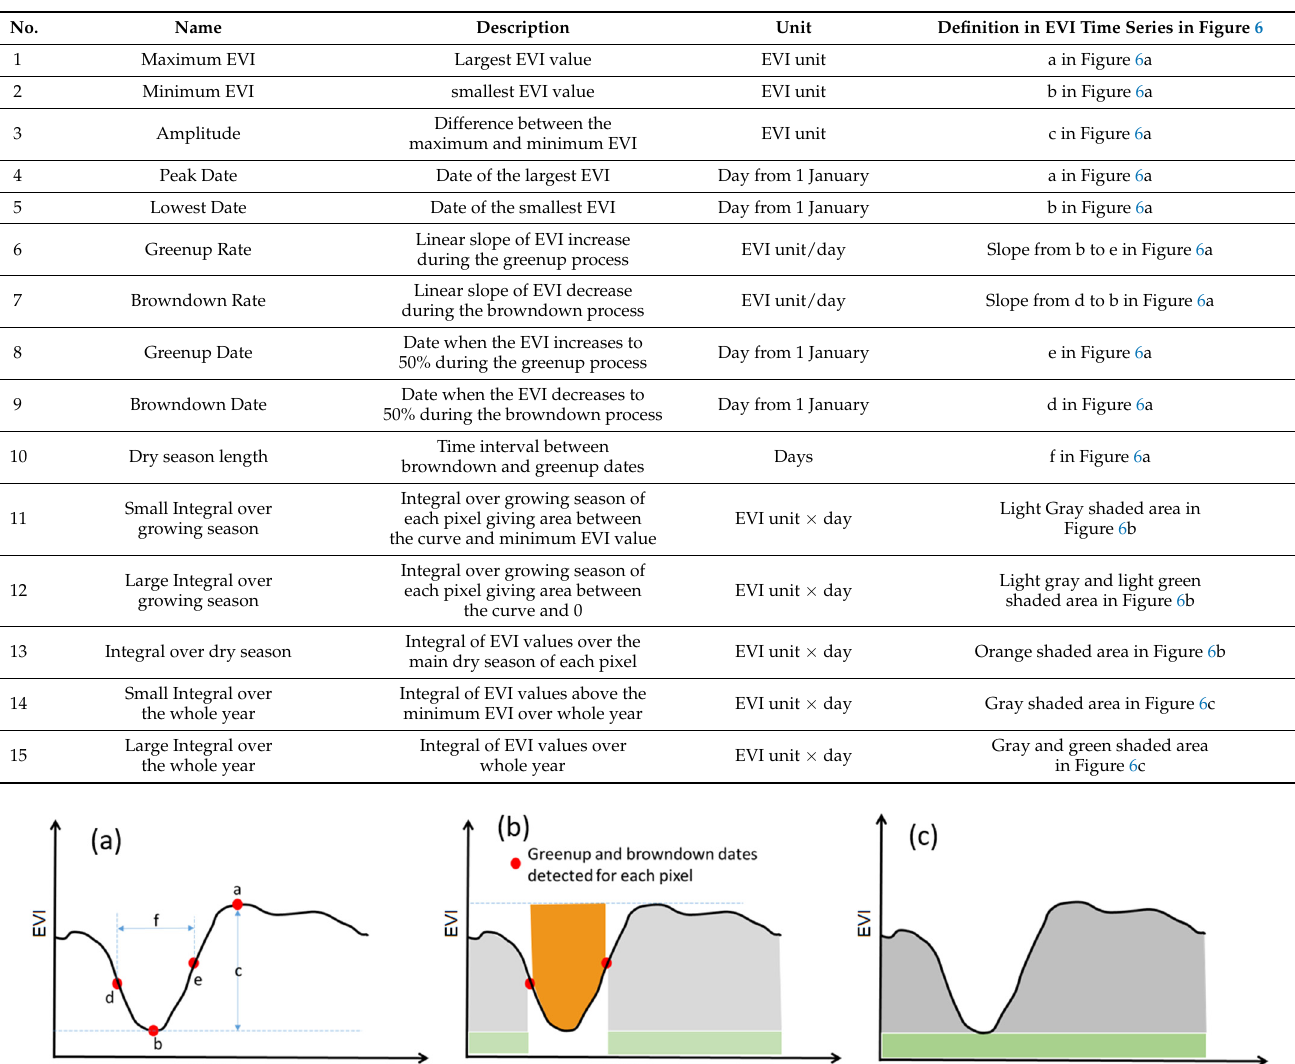
Table 2. 15 dry-season phenological metrics extracted from the EVI time series.